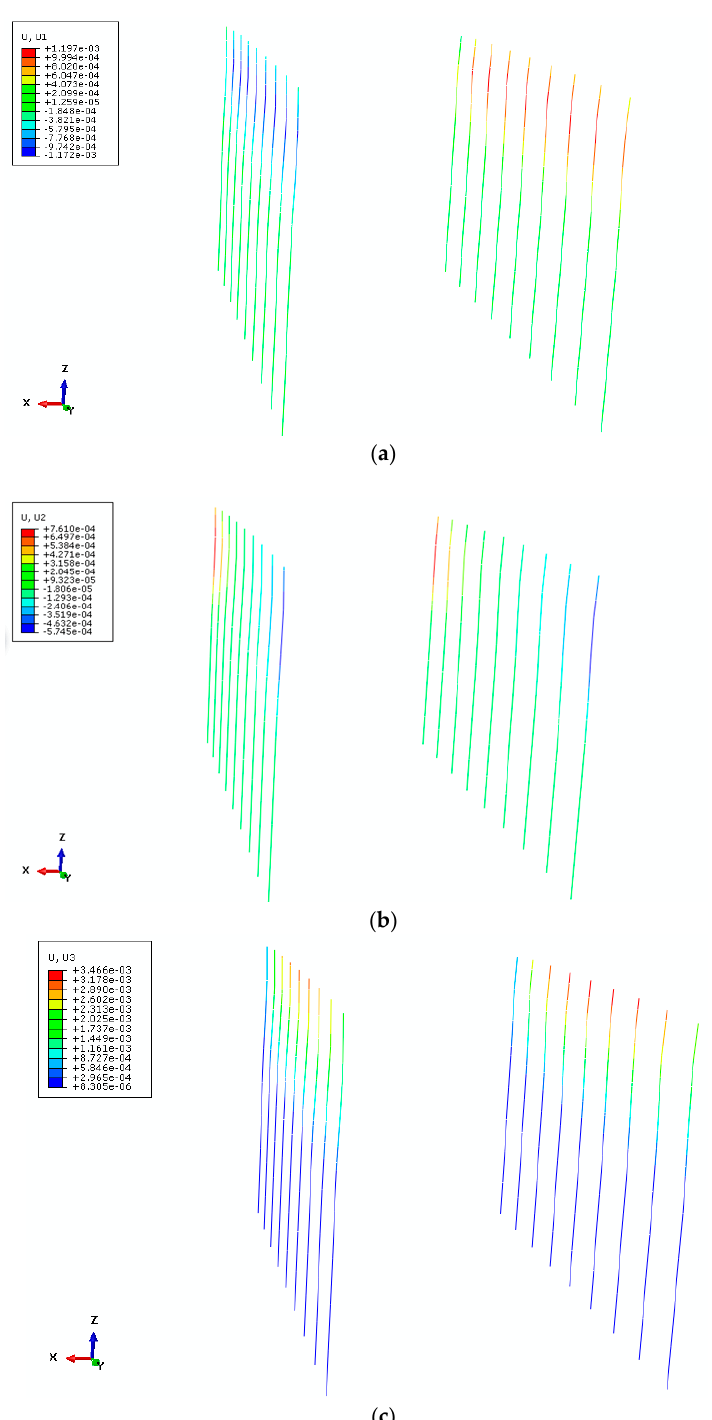
Figure 12. Deformation cloud of the left retaining pile. ( a ) x direction; ( b ) y direction; ( c ) z direction.